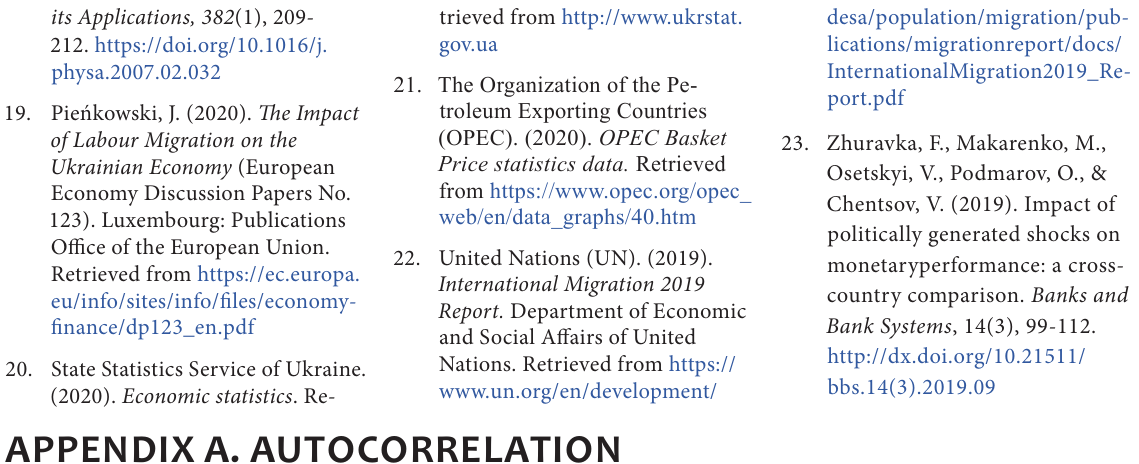
Table A1. Autocorrelation coefficients, USD/UAH exchange rate, 2014 – May 2020 (in absolute values and in first